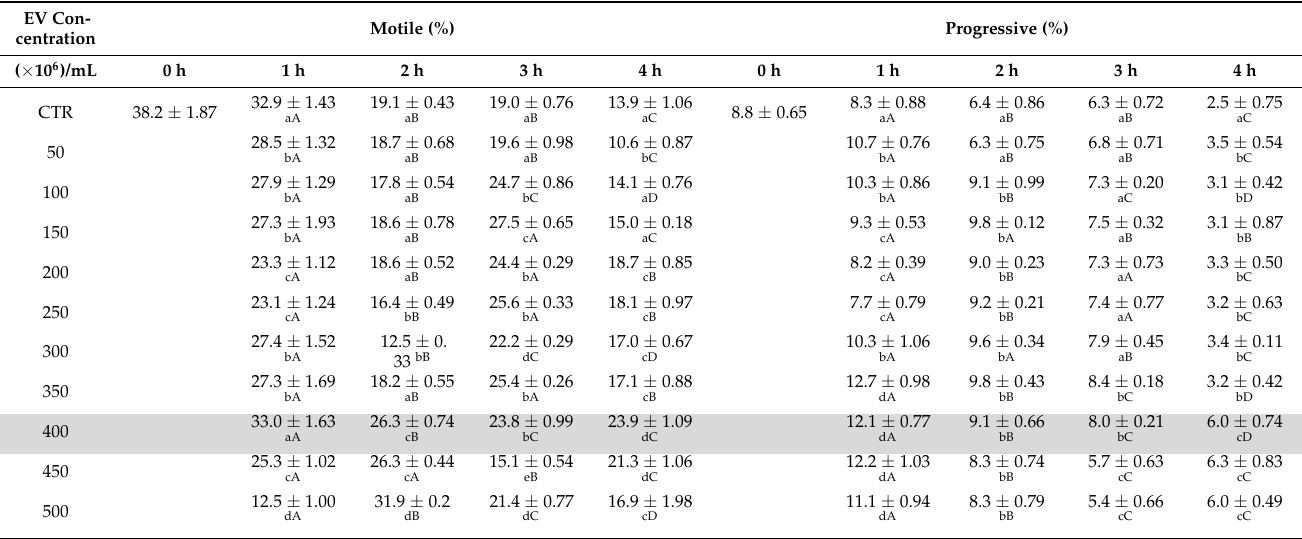
(Supplementary Table S1). Similarly, AHL (which detects the movement of the head of spermatozoa, indicating a wave motion) was unaltered at this concentration compared to the control for all the time points. Interestingly, at the concentration of 400 × 10 6 EVs/mL, the linearity parameter (LIN) increased after the first and second hours and remained statistically higher throughout the incubation period compared to the control. In the same way, STR values did not differ from the control at the first and third hours, while they rose during the second and fourth hours (Supplementary Tables S2 and S3). Conversely, since it caused an enhancement of the lateral movement of the head (the AHL parameter increased), resulting in a reduction in LIN and STR values, 300 × 10 6 EVs/mL was considered the worst concentration tested. Table 1. Total motility and progressive motility concentration of sperm treated at different times with different concentrations of EVs, compared to